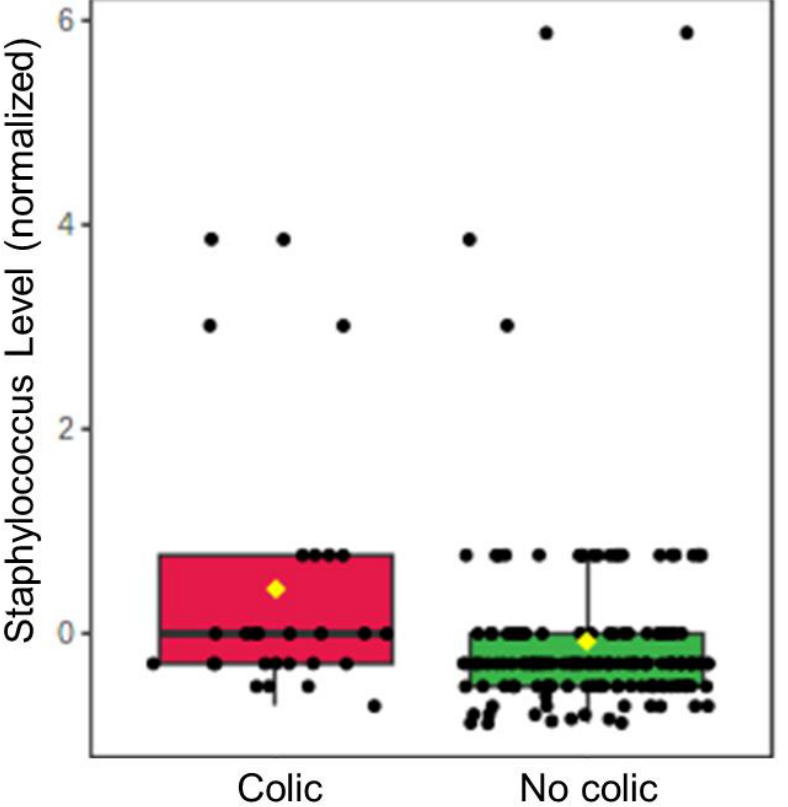
Figure 4. Levels of Staphylococcus in human milk are higher among mothers of infants with colic. The boxplot displays levels of Staphylococcus in human milk obtained at one month from mothers of infants with (red) and without colic (green). Quantile normalized levels of Staphylococcus transcripts were higher in samples from the colic group ( p = 0.0076, adj. p = 0.038, d = 0.30) on Mann – Whitney testing. Mean (yellow diamond), median (black bar), and standard deviation are displayed.